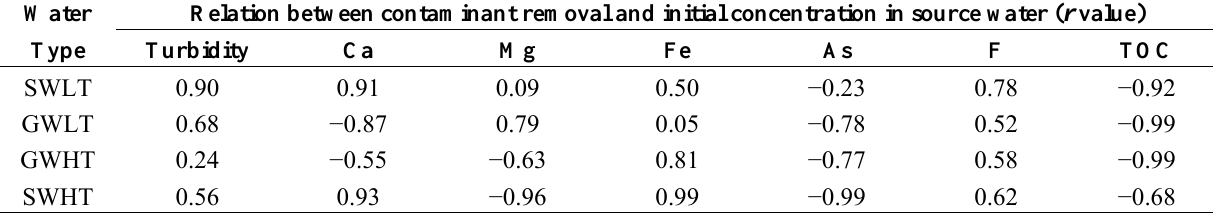
Table 4. Correlation between observed reductions and initial feed water